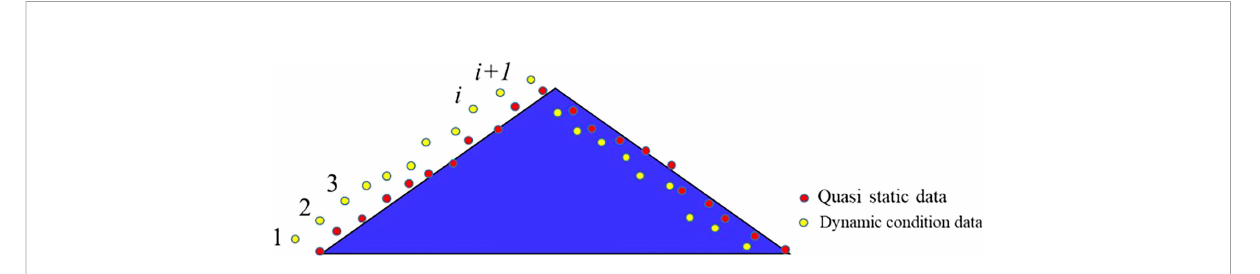
FIGURE 7 Location diagram of dynamic detection and static detection results. In order to further obtain the relationship between motion speed and ultrasonic detection lag, the detection data obtained at different motion speeds are standard discretized, and the data obtained at no motion speed is compared with 0.05m/s data.